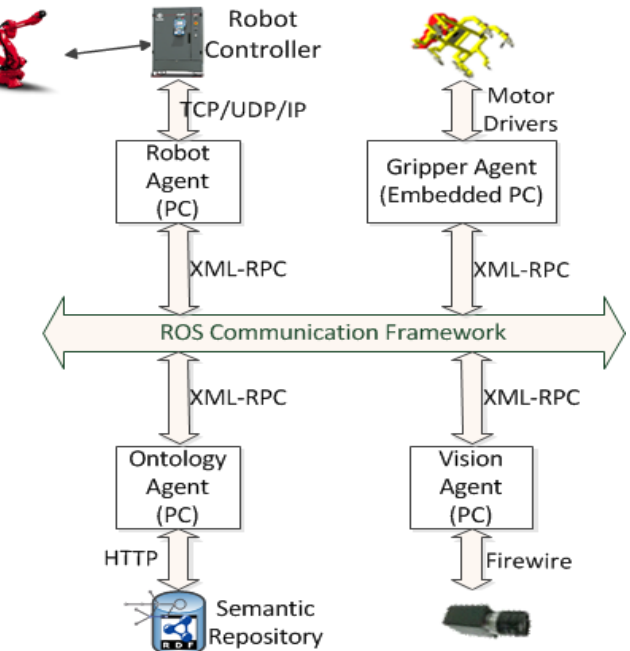
Figure 2. Agent relationship and interaction diagram for the multi-agent framework. User Datagram